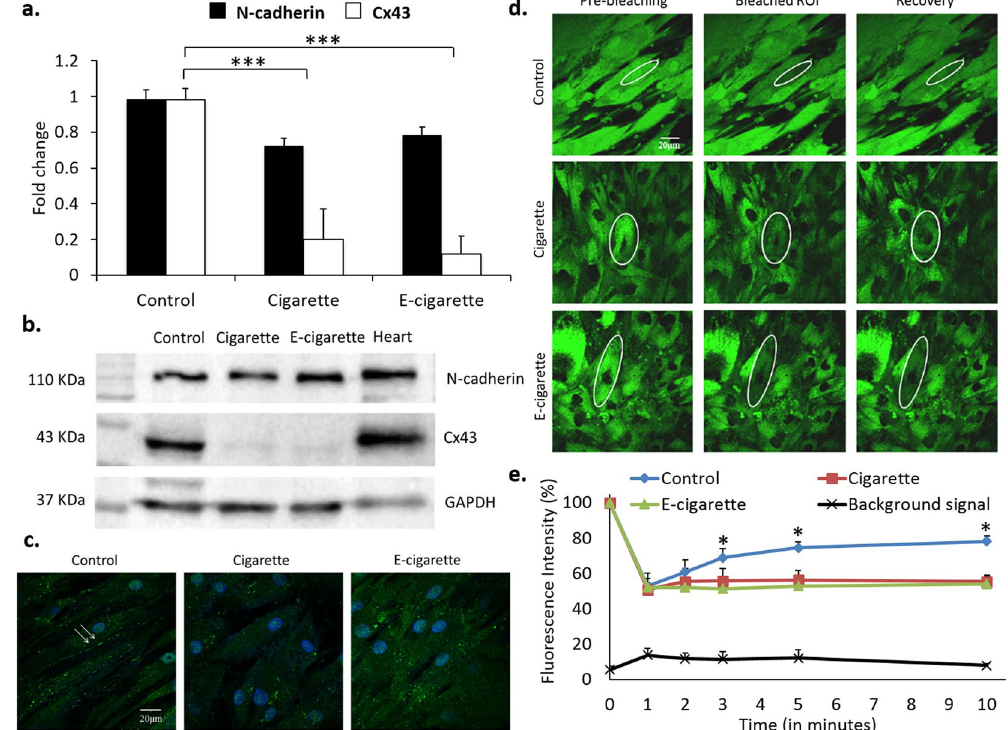
Figure 5. Cigarette and e-cigarette smoke extracts inhibit cell-cell communication in MSCs. MSCs were treated with cigarette and e-cigarette smoke extracts for 14 days. ( a ) qRT-PCR of Cx43 and N-cadherin was performed on total RNA obtained from control and treated cells. Data were normalized against GAPDH and show fold changes (averages ± SEM of 3 independent experiments) relative to the control. ( b ) Western blots of Cx43 and N-cadherin were performed on total protein extracts obtained from control and treated cells. GAPDH was used as a loading control and total heart lysates as a technical positive control. Blots are representative of 3 independent experiments. ( c ) Immunofluorescence staining of Cx43 was performed on control and treated MSCs. Arrows indicate gap junction plaques between adjacent cells. Images are representative of at least 10 fields from 2 independent experiments. ( d ) MSCs from the control and treated wells were stained with calcein-AM and then subjected to 50% photo-bleaching by the 488-nm laser. Fluorescence recovery after photo- bleaching (FRAP) was monitored for 10 minutes under the 63X objective. White ellipses indicate regions of interest (ROI). Images are representative of at least 5 ROIs per condition, from 2 independent experiments. ( e ) Quantification of fluorescence intensity of ROIs relative to reference cells of control and treated cells. Values represent the fluorescence intensity (averages ± SD) of each ROI based on several measurements calculated by the Zeiss Zen 2011 software. * p < 0.05 and *** p <